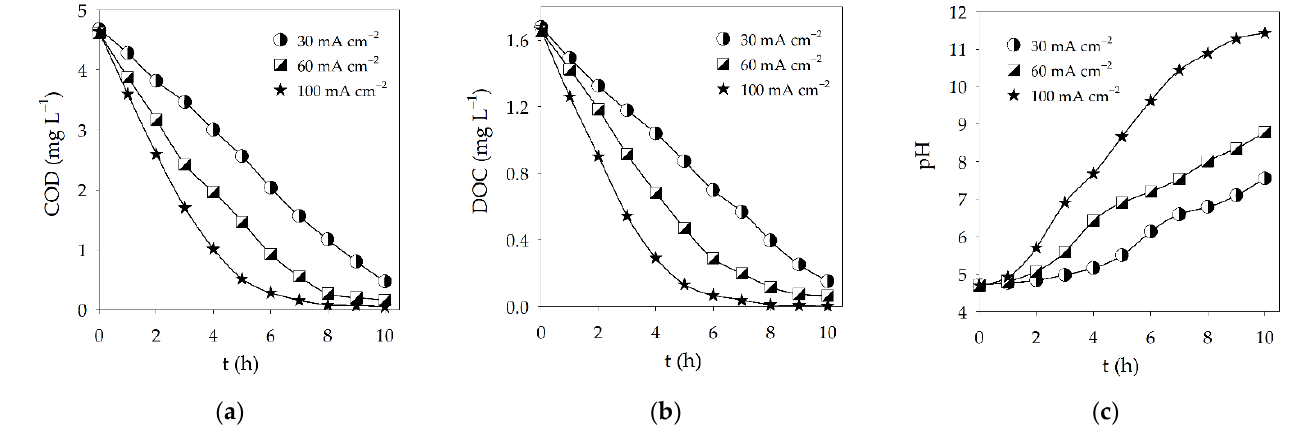
Figure 4. Variation in time of ( a ) COD; ( b ) DOC, and ( c ) pH, during the preliminary EO experiments performed at different j .